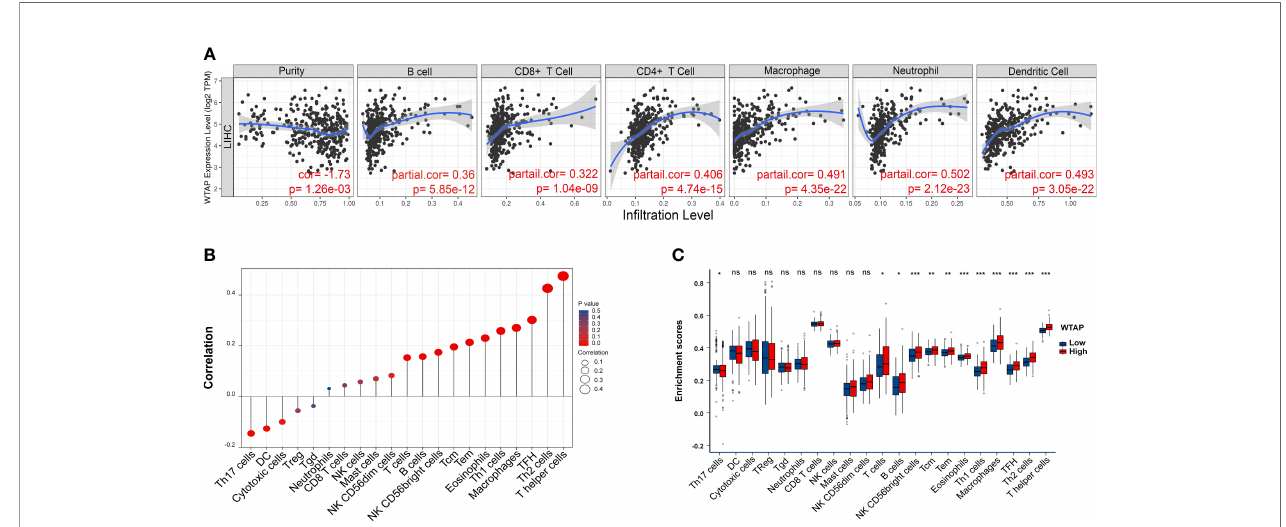
FIGURE 5 | (A) WTAP expression is correlated with the degree of in fi ltration of CD4+ T cells, CD8+ T cells, macrophages, B cells, myeloid dendritic cells, and neutrophils in HCC tissues. (B) Correlation between the relative abundance of 21 immune cell types and WTAP expression levels. Dot sizes represent the absolute value of Spearman R. (C) Box diagram showing differences in degrees of in fi ltration of 21 immune cells between WTAP high- and low-expression groups. * P < 0.05, ** P < 0.01 and *** P < 0.001 respectively. "ns" not statistically signi fi